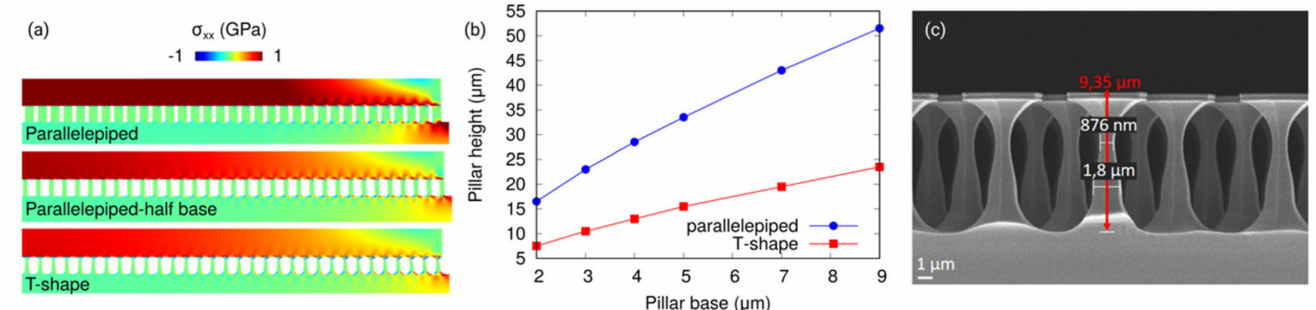
Figure 6. ( a ) Color maps of the xx component of the stress tensor ( σ xx ) for three 3C-SiC epilayers grown on array of pillars with different geometries. Top: parallelepiped pillars, spaced by 2 µ m and with a base width of 5 µ m. Center: parallelepiped pillars, spaced by 4.5 µ m and with a base width of 2.5 µ m. Bottom: T-shape pillars, spaced by 2 µ m and with a maximum base width of 5 µ m. ( b ) Plot of the height of the pillars as a function of the width of the pillars that is needed to guarantee a curvature radius of the sample that is larger than 10 m (acceptable for post-processing of 4 (cid:48) wafers). A (111) Si substrate is considered. ( c ) SEM image of the T-shape pillars (adapted from Reference